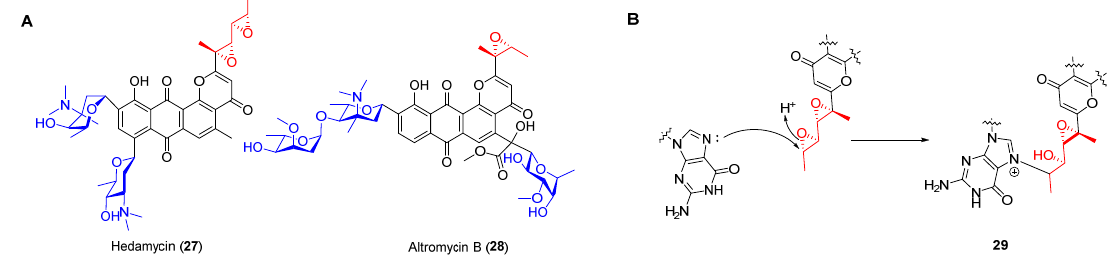
Figure 6. ( A ) Chemical structures of pluramycins. ( B ) Alkylation of DNA by hedamycin.